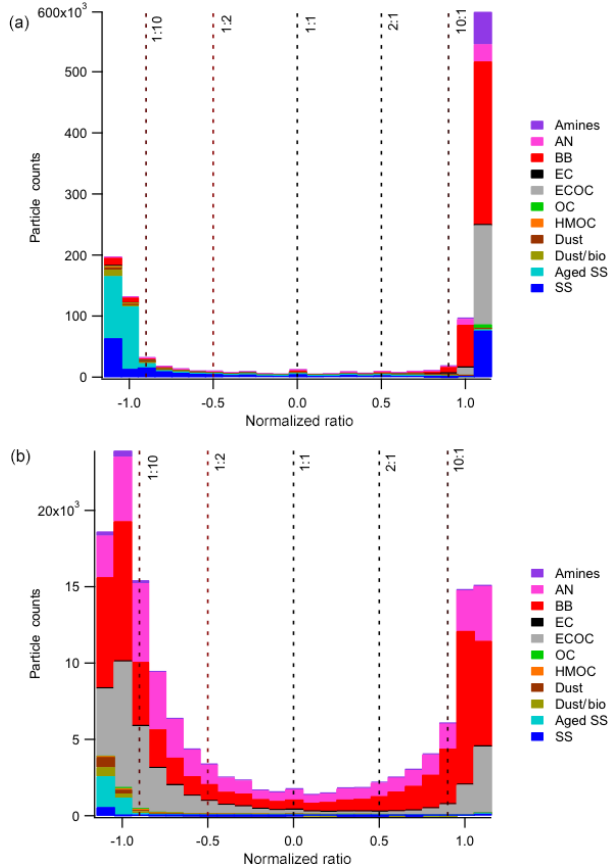
Figure 7. (a) Particle sulfate:nitrate ion ratio distribution for CTL periods. Values < 0 indicate more nitrate than sulfate, and values > 0 indicate more sulfate than nitrate. Ratios representing 1:1, 2:1, and 10:1 are shown by vertical dashed lines. Significant particle types are represented by separate colors. (b) as in (a) but during PGF